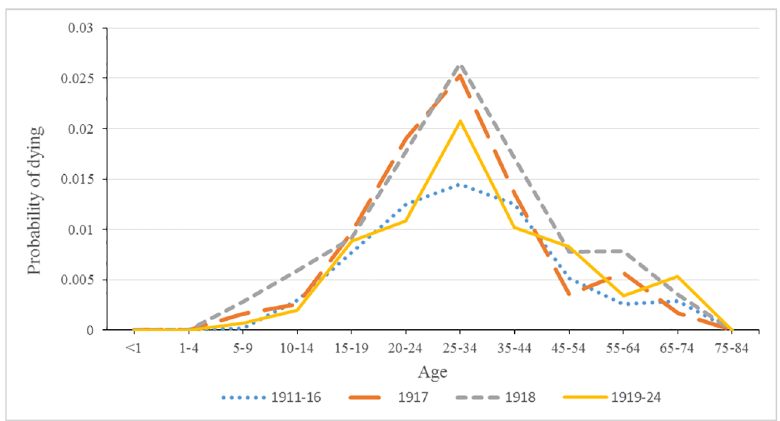
Fig 5. Female probability of dying from tuberculosis for four time